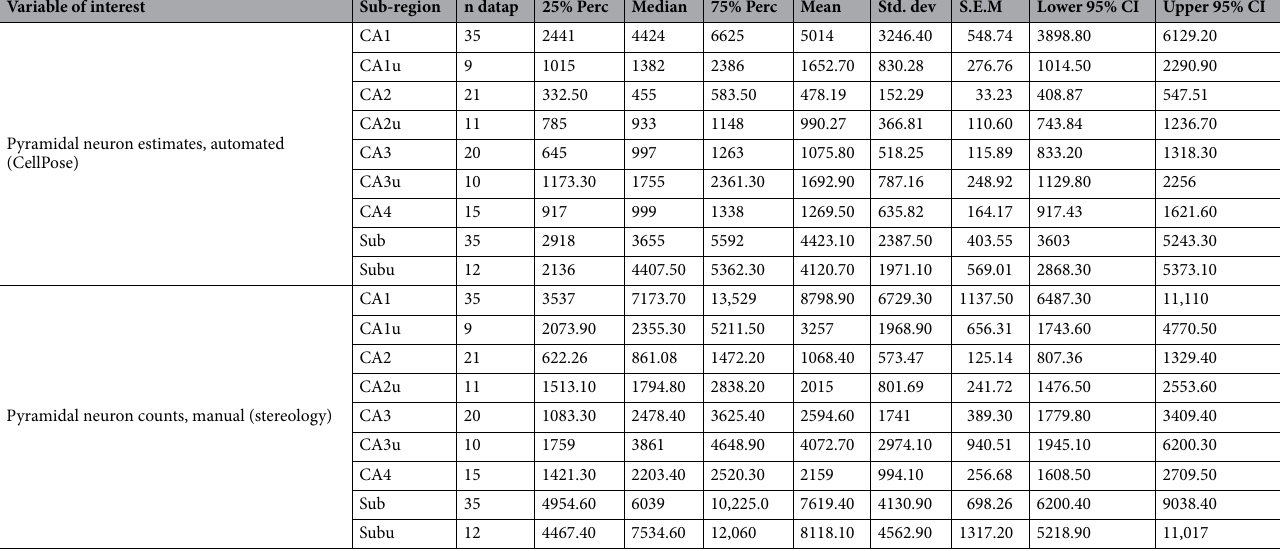
Table 2. Descriptive statistics of hippocampal subregion CellPose pyramidal neuron estimates and manual neuron counts. 25% percentile, median, 75% percentile, mean, std. dev., S.E.M., lower 95% confidence interval and upper 95% confidence interval. In both methods CA1 displays the largest variability and neuron